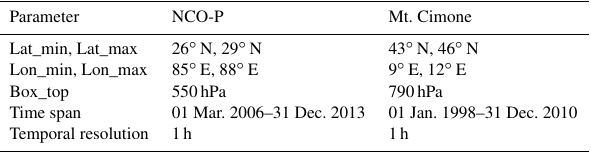
Table 1. Input parameters for STEFLUX for the comparison with in situ measurements